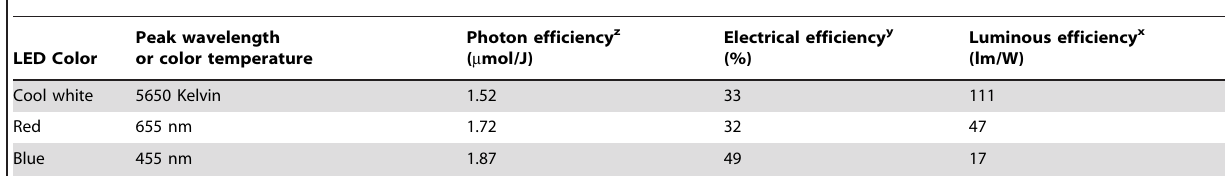
Peak wavelength or color temperature